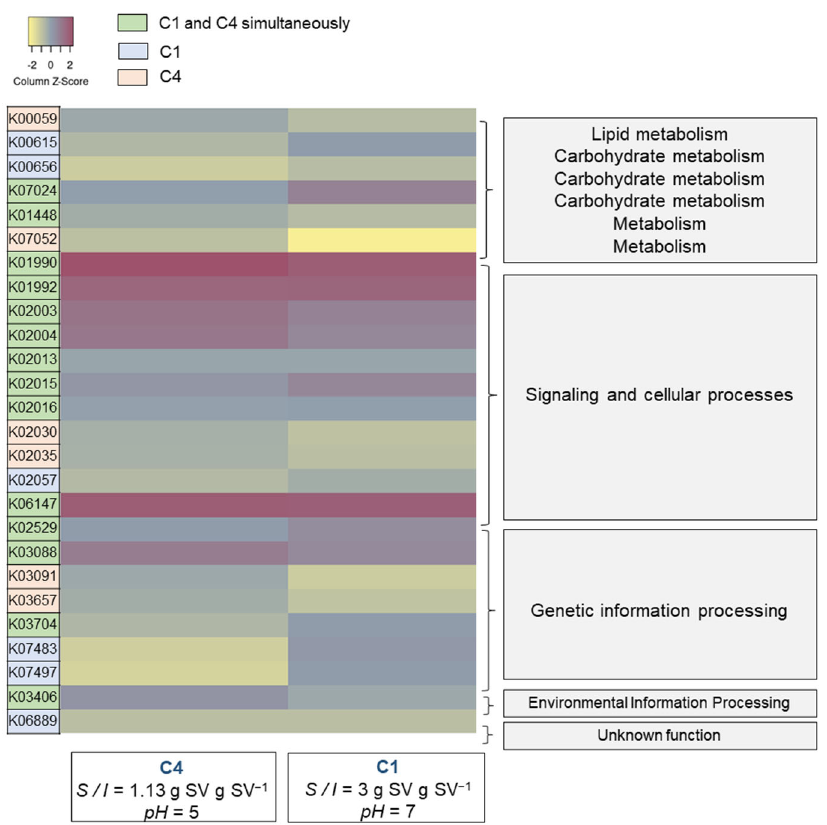
Figure 5. Heatmaps of the main functional pathways involved in VFAs production using conditions 1 (C1) and 4